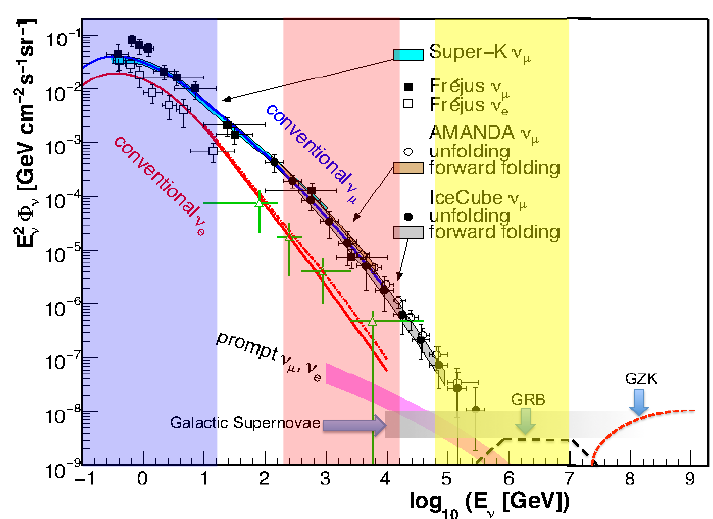
Figure 23.1: Atmospheric neutrino flux, with data from different experiments, the first two shaded regions(blue, red) show the approximate range of real neutrino energy for the low and high energy data samples used to perform oscillation analysis by IceCube. The energy range of the measured astrophysical neutrinos is shown in